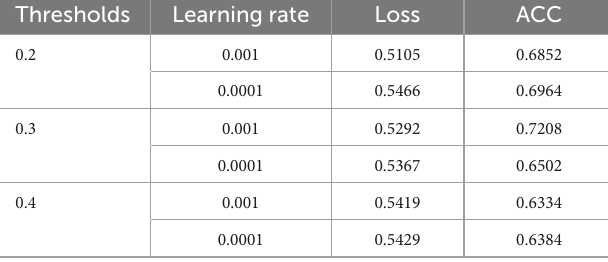
TABLE 6 Loss and accurate value under different thresholds and learning rates. Thresholds